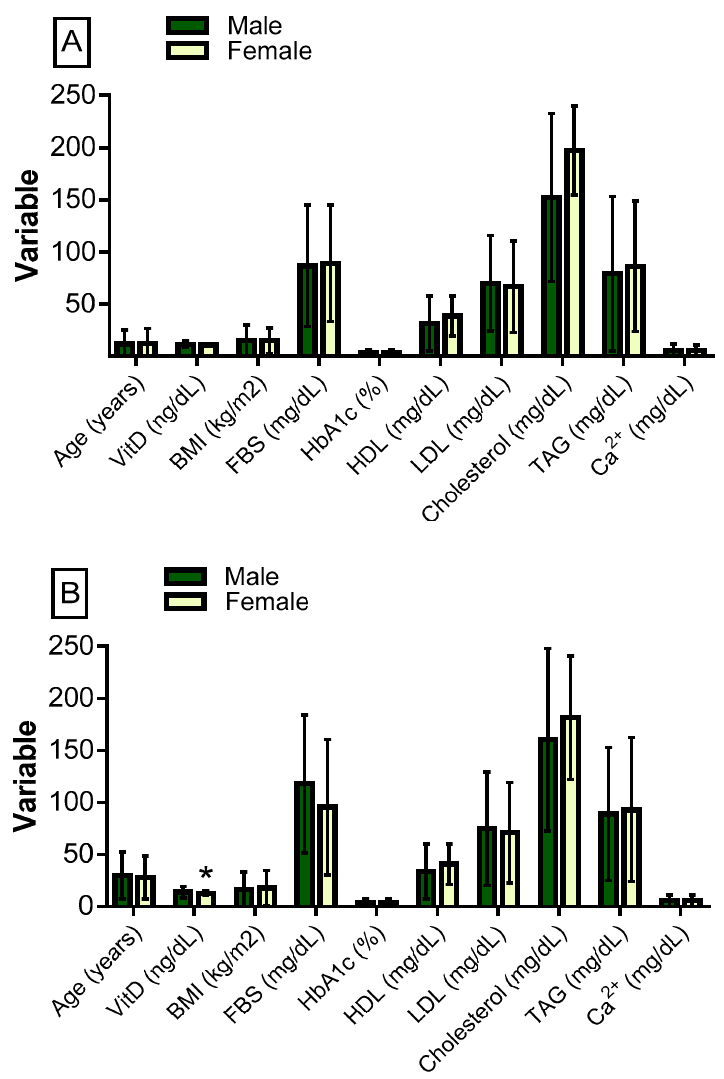
Figure 3. Mean age, VitD status, and other health indicators in Libyans according to the sex within the two age groups ( A ) young adults and ( B ) adults. N = number; % = percentage within age group; BMI = body mass index; FBS = fasting blood sugar; HbA1c = glycosylated hemoglobin; HDL = high-density lipoproteins; LDL = low-density lipoproteins; TAG = triglycerides; Ca 2+ = calcium; VitD = vitamin D. ( * ) indicates p < 0.05 .